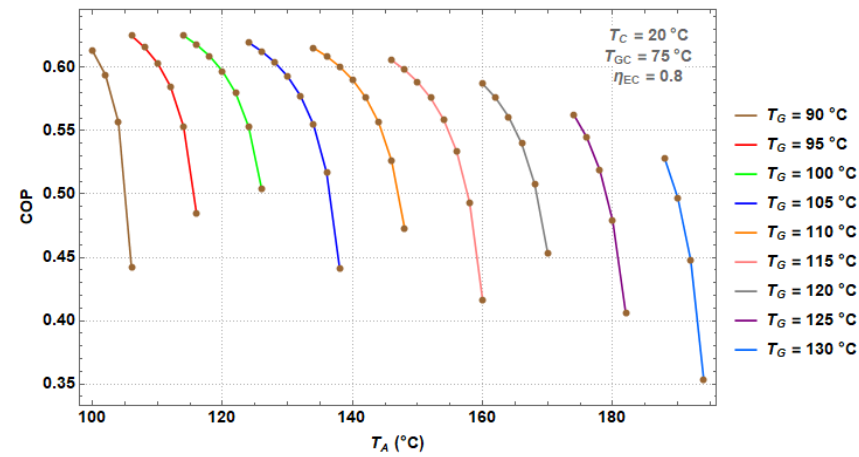
Figure 4. COP as a function of T A at different T G values for the DEHT.